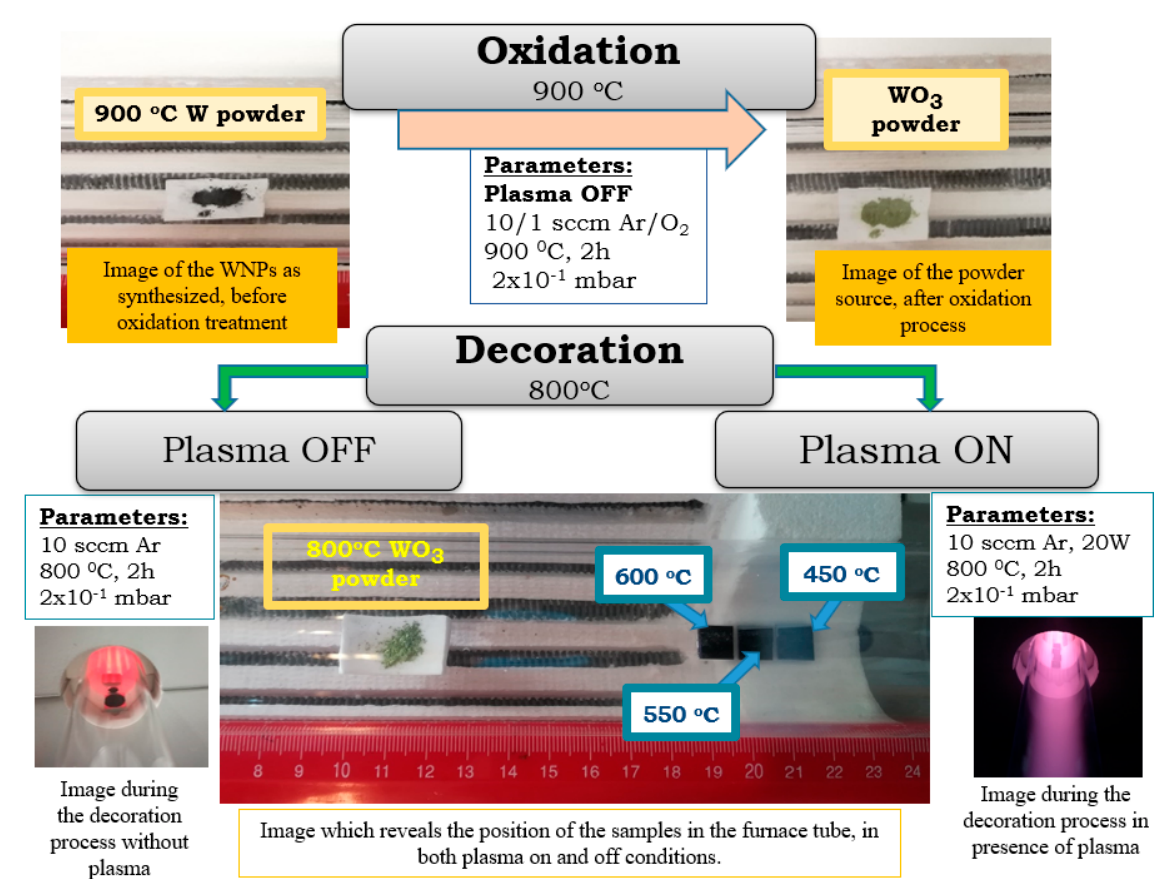
Figure 2. The schematic representation of the oxidation and decoration processes used for the hybrid nanostructures syn- thesis.